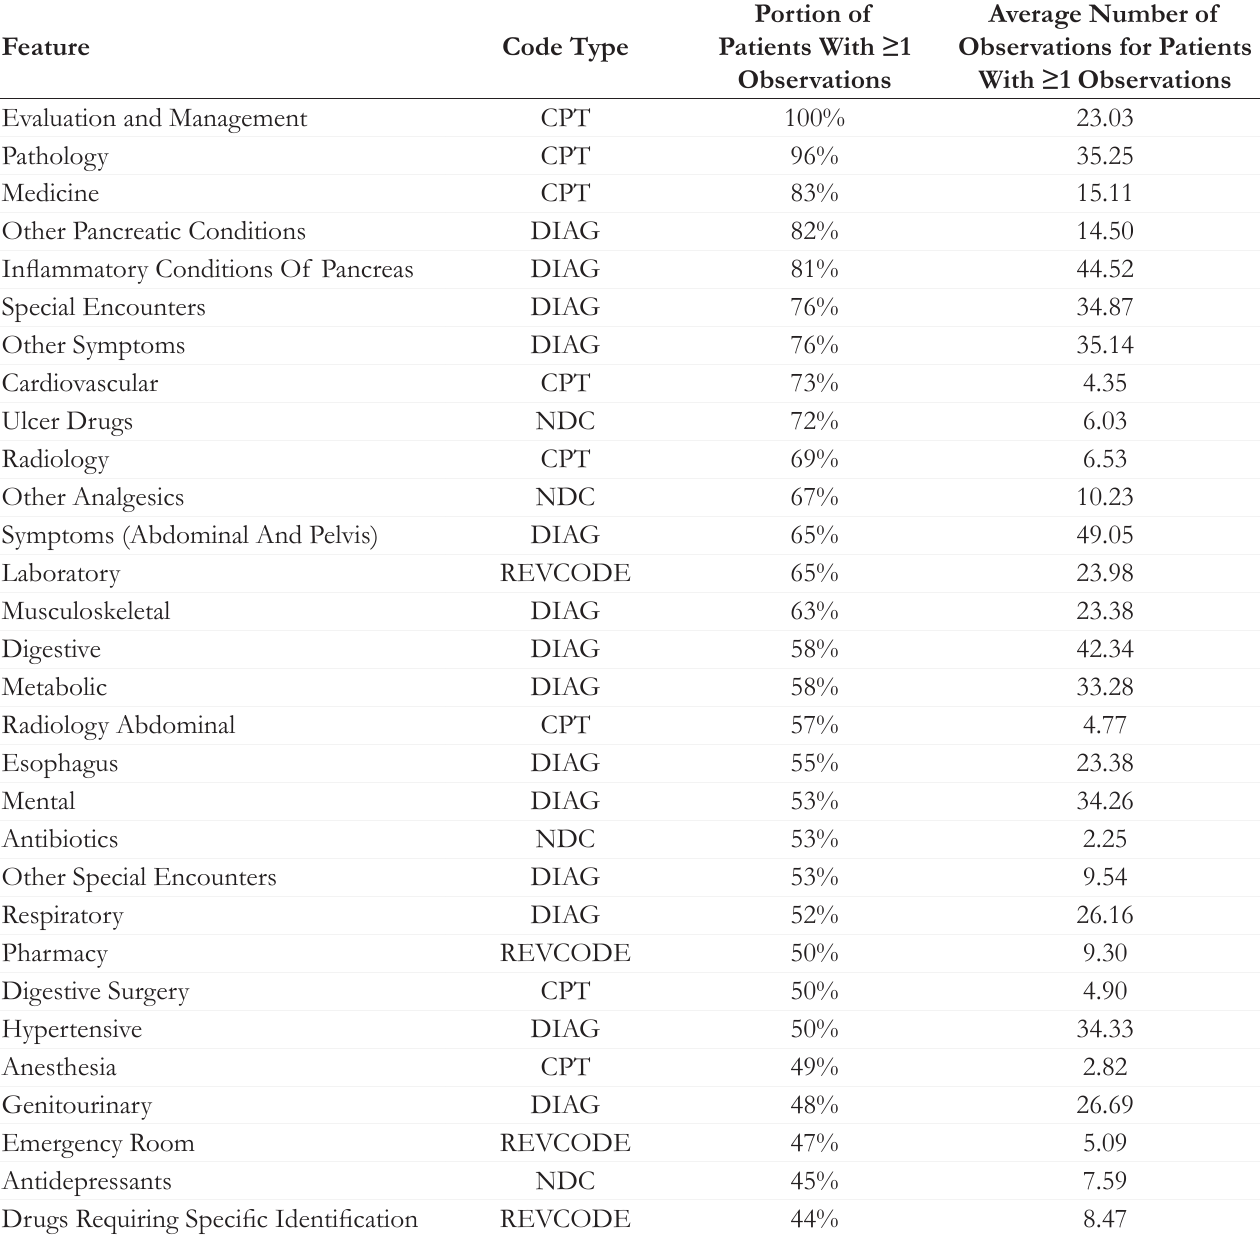
Table 6b. Most Frequent Features in Patients with 80% to 90% EPI Probability